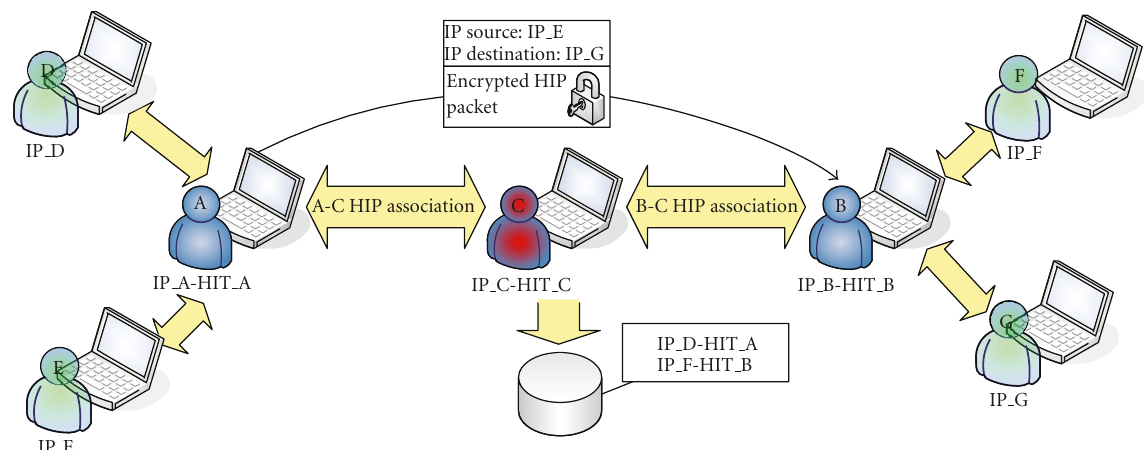
Figure 4: Example of the use of pseudonyms in the scope of